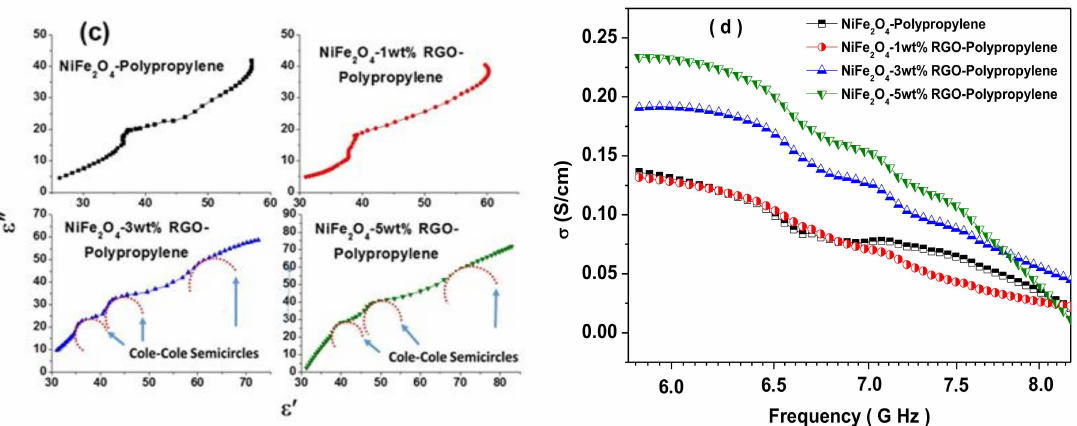
Figure 11. ( a ) Real part of the permittivity of the prepared nanocomposite, ( b ) imaginary part